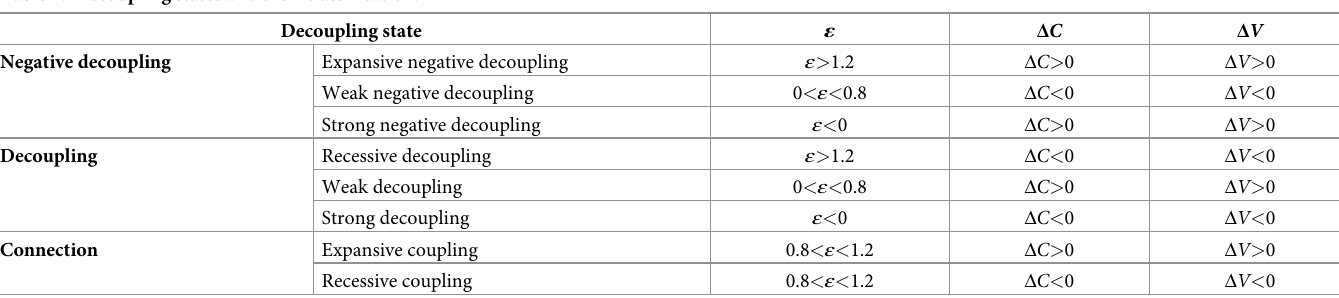
Table 2. Decoupling states and their